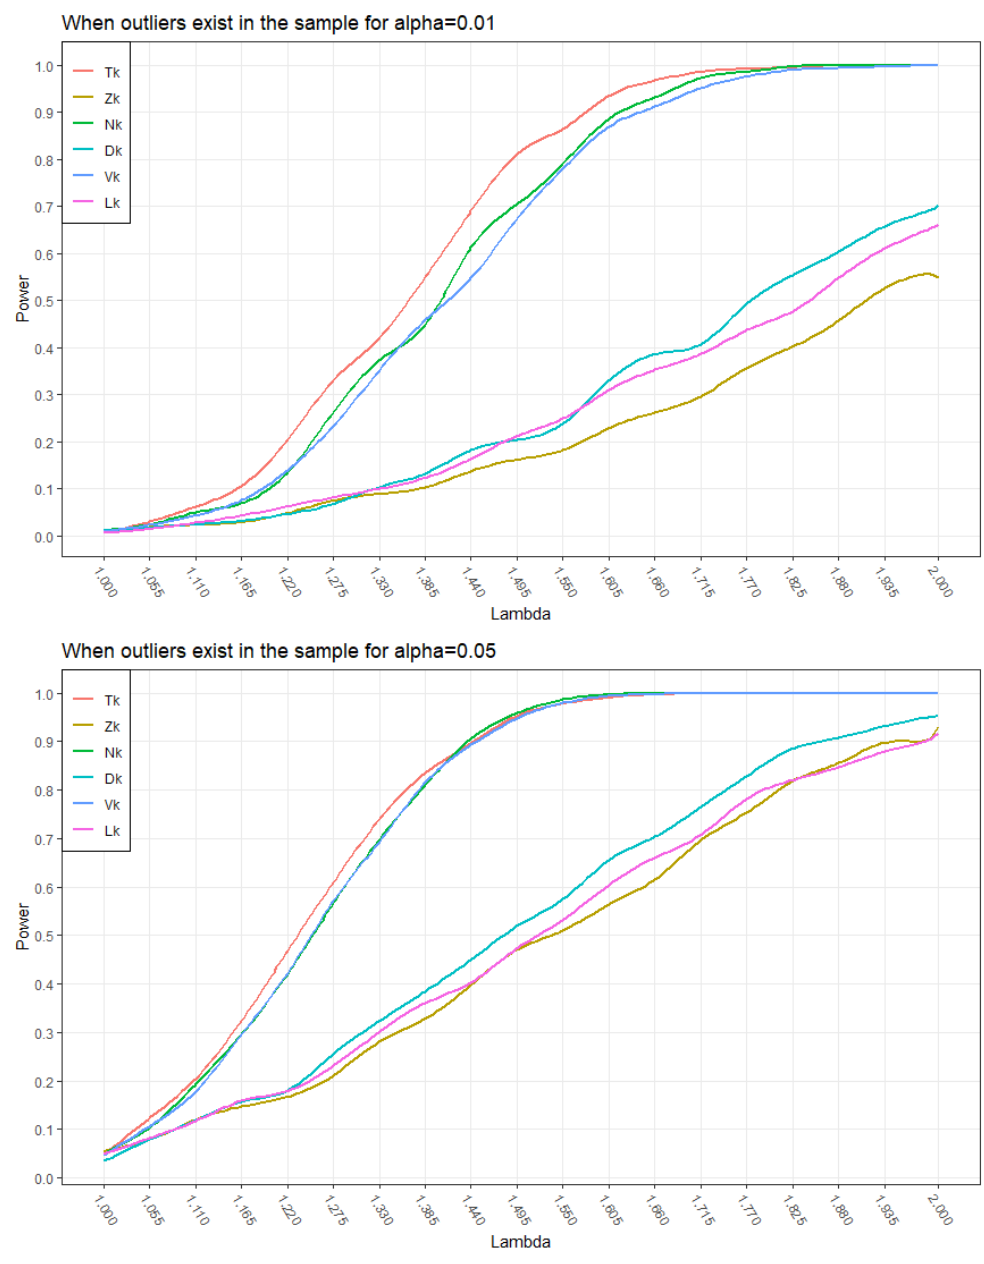
Figure 2. Power of test statistics for m = 5, k = 5, and n =